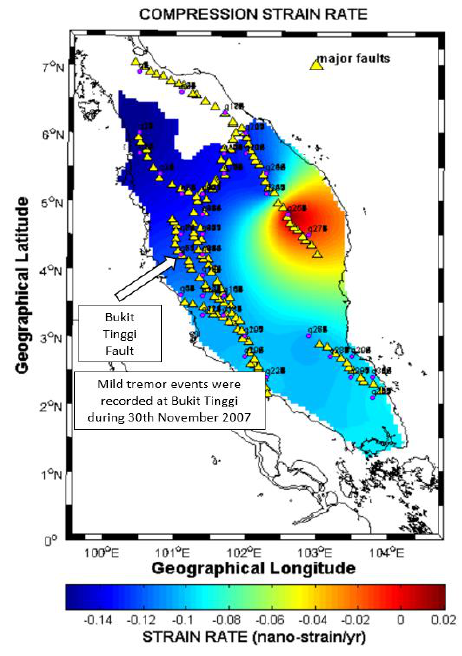
Figure 17. Strain rate (Compression) map contour over Peninsular Malaysia